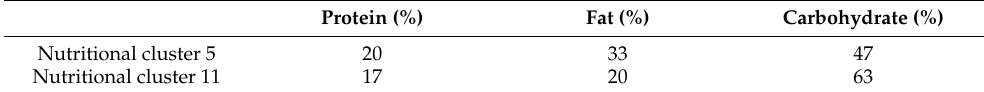
Table 4. The protein:fat:carbohydrate ratios of nutritional clusters 5 and 11. Protein (%) Fat